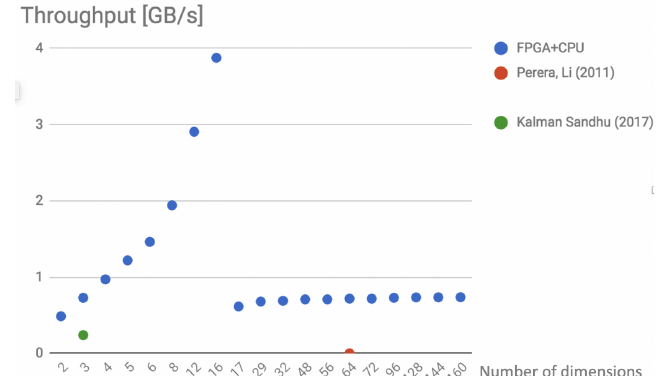
Figure 3. Throughput of the presented design, and the baselines [6], [11]. Note that the current imple- mentation has variable input dimensionality, whereas the baseline designs have fixed dimensionality.